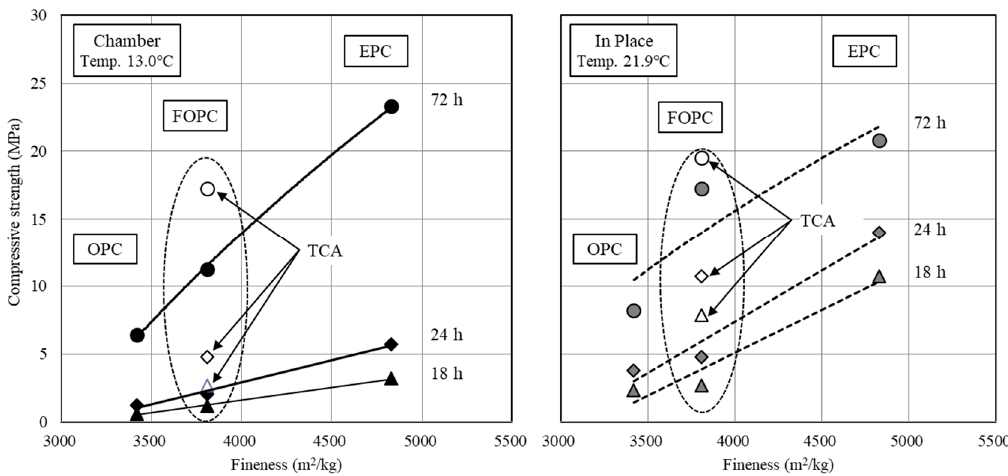
Figure 10. Comparison of cement fineness and early strength of concrete.